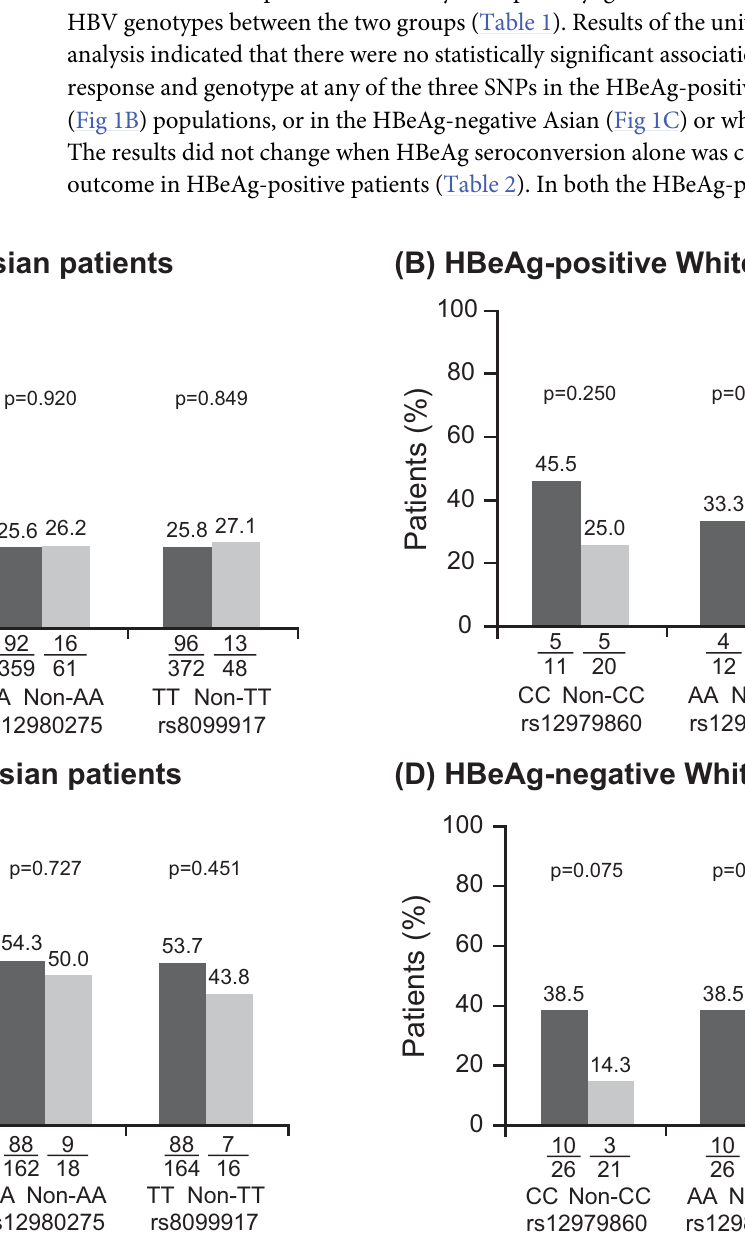
Fig 1. Response rates according to host IFNL3 genotype. Response rates according to genotype at rs12980275, rs12979860, and rs8099917 in HBeAg-positive Asian (A) and white (B) patients, and in HBeAg-negative Asian (C) and white (D) patients. Some patients did not have data available for all genotypes, and response rates are calculated on the basis of the number of patients with